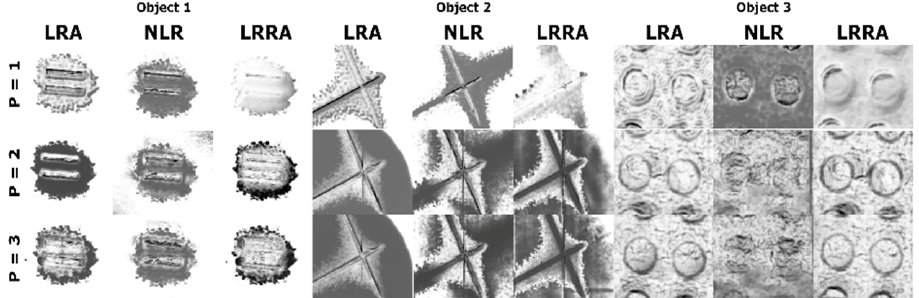
Figure 10. SSIM maps for the test objects with respect to the direct imaging and the reconstruction results using LRA, NLR and LRRA. The colormap follows usual grayscale with black being least similarity and white being highest similarity.